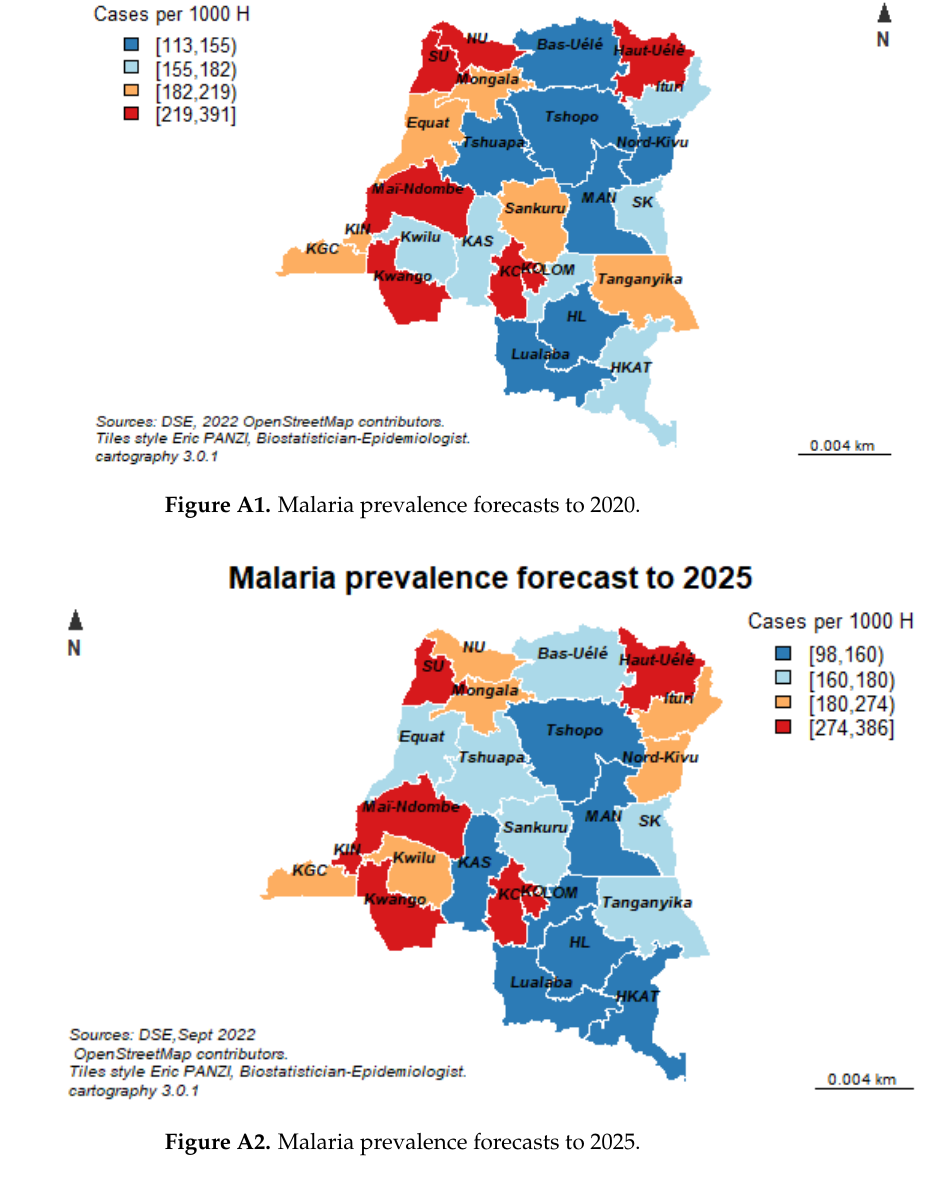
Figure A3. Malaria prevalence forecasts to 2030.